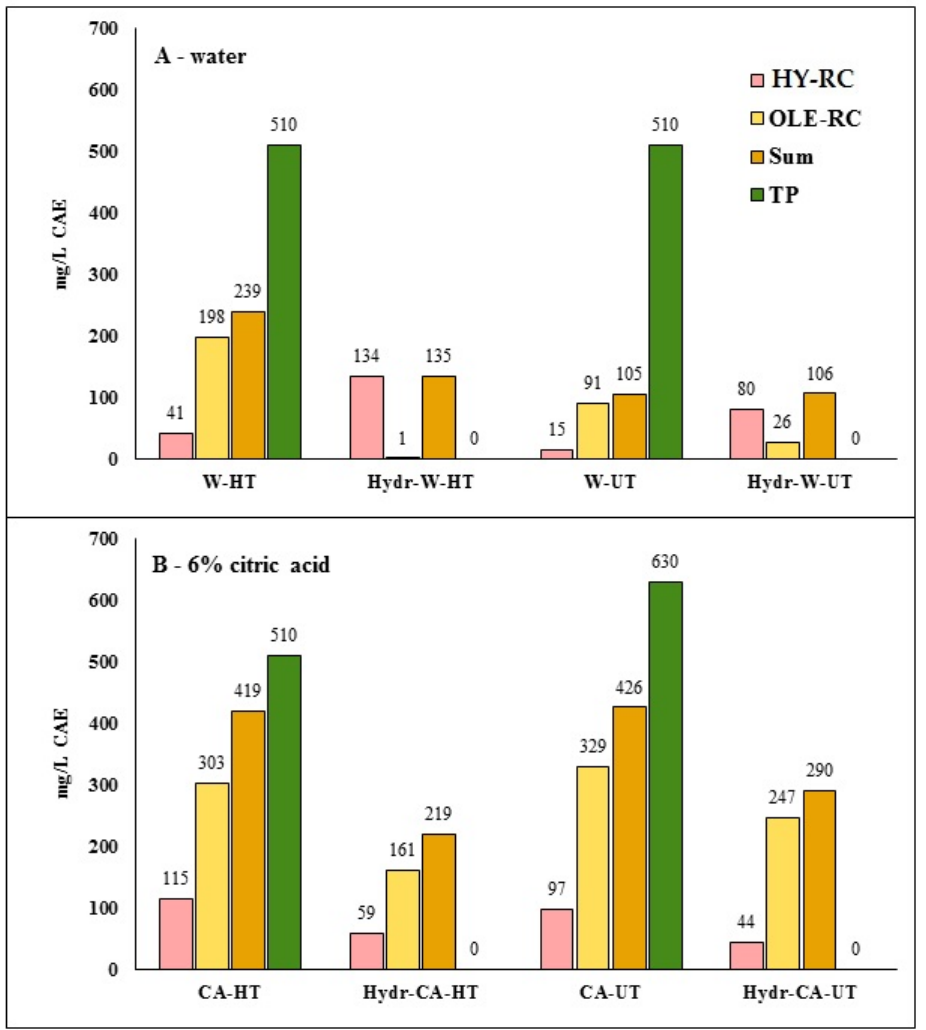
Figure 4. Phenolic profile of fresh and HCl-heat hydrolyzed (Hydr-) functional beverages deter- mined by HPLC analyses (HY-RC, hydroxytyrosol related compounds; OLE-RC, oleuropein related compounds; SUM of HY-RC and OLE-RC) and Folin Ciocalteu’s method (TP, Total phenols). OLE-RC was about thrree-times higher than HY-RC in all FBs. Conversely, the SUM of HY-RC and OLE-RC was higher in CA-FB than W-FB. The SUM on TP in percent-